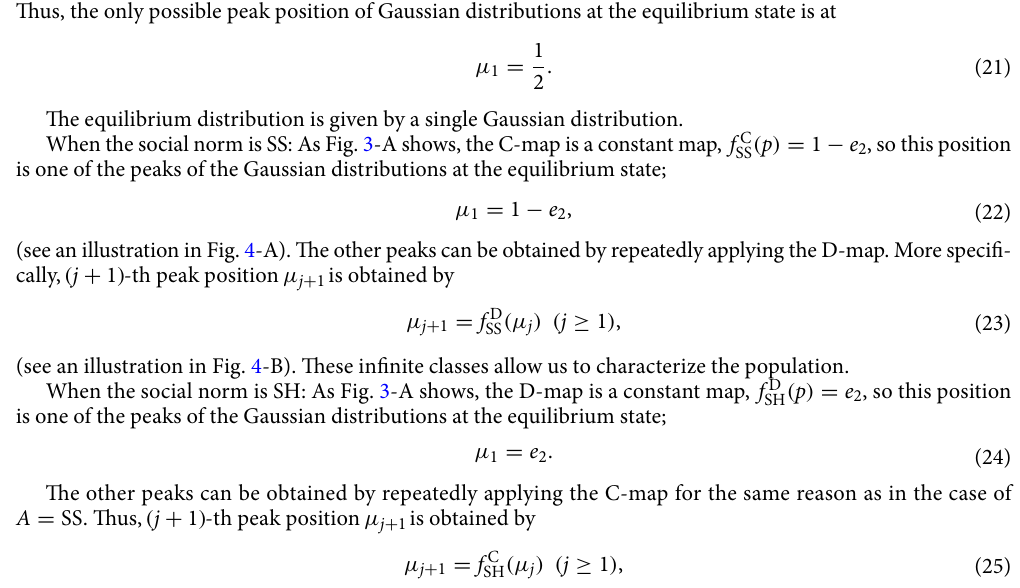
Figure 3. ( A ) C-map f C A (solid line) and D-map f D A (broken line). We have used e 1 SJ, SS, SH, SC . Black solid line indicates an identity map. ( B ) Illustration of right, the panels show cases of A = f ( p ∗ ) by sequential application of a map f . Because slopes of all C-maps and D-maps reaching a fixed point p ∗ = 1 , the fixed point is always are less than 1 and greater than −